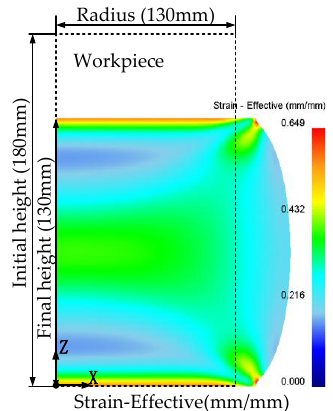
Figure 2. Dimensions and equivalent strain during upsetting.